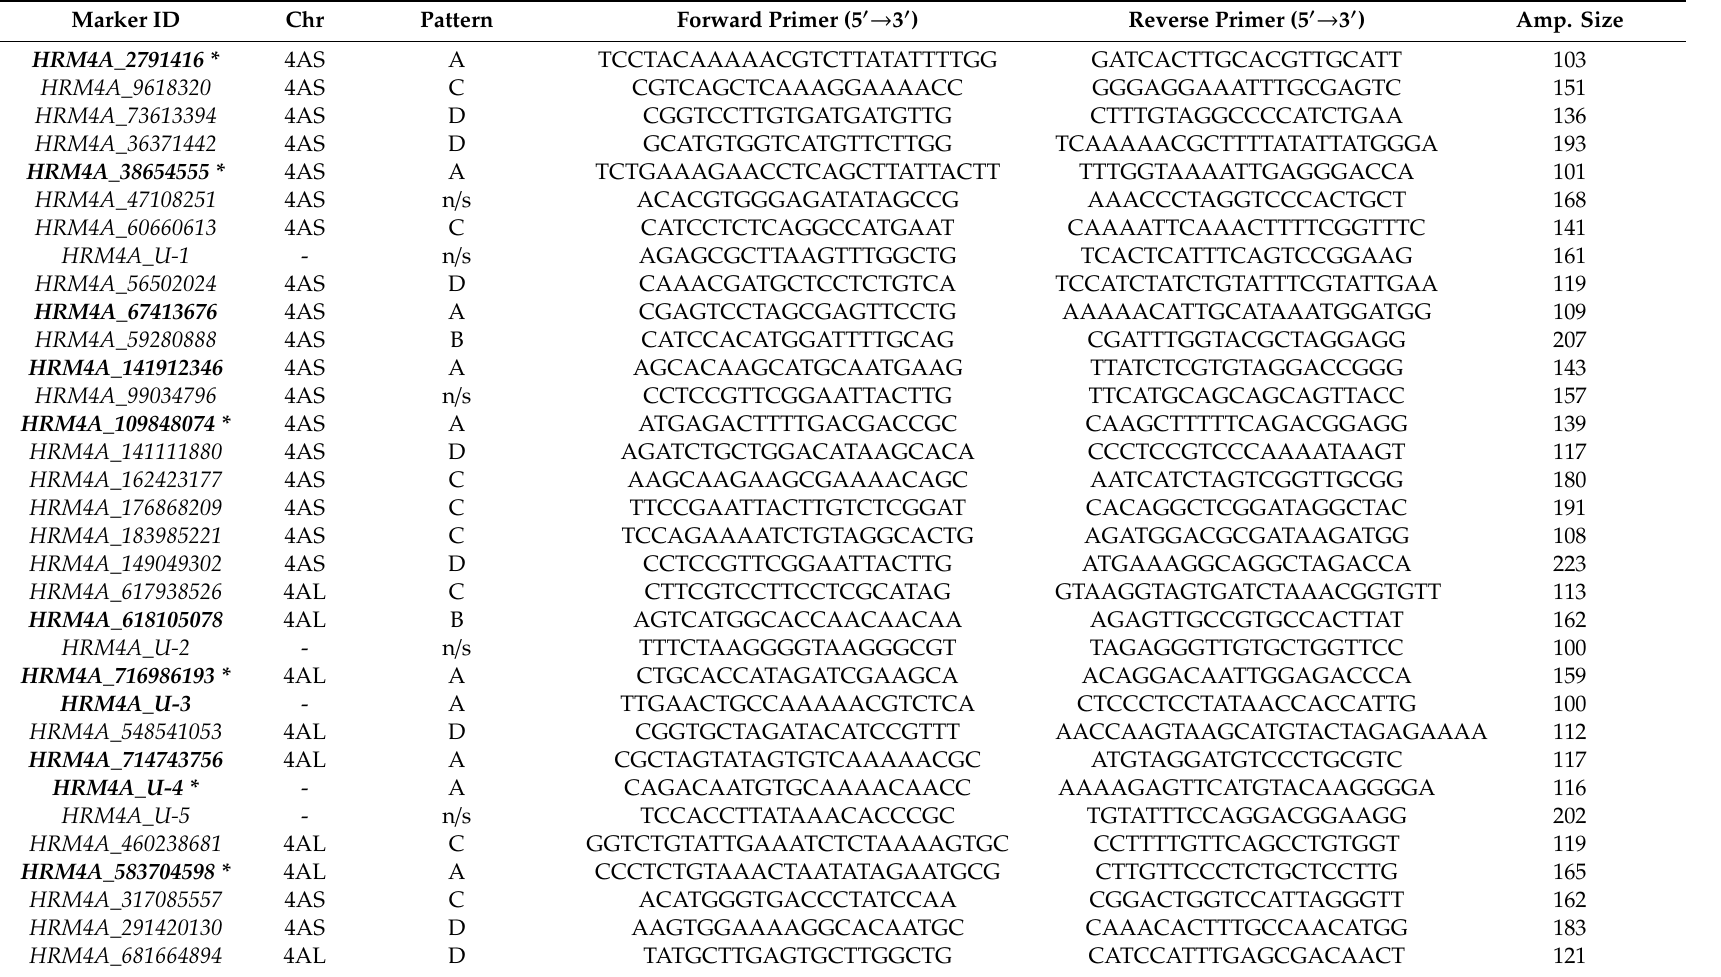
Table 1. Insertion site-based polymorphism markers developed for wheat chromosome 4A. ISBP primers selected for the wheat collection variability assessment are shown in